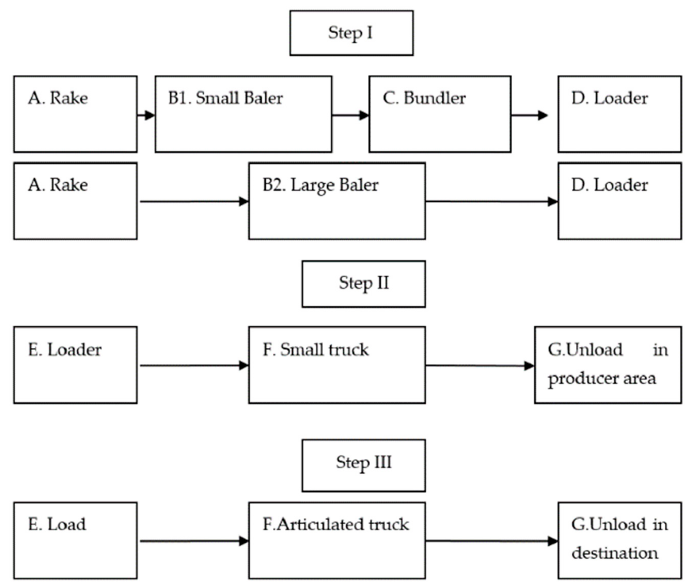
Figure 2. Diagram of operations.